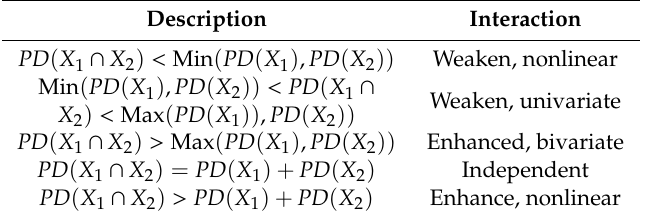
Table 2. Types of interaction between two covariates